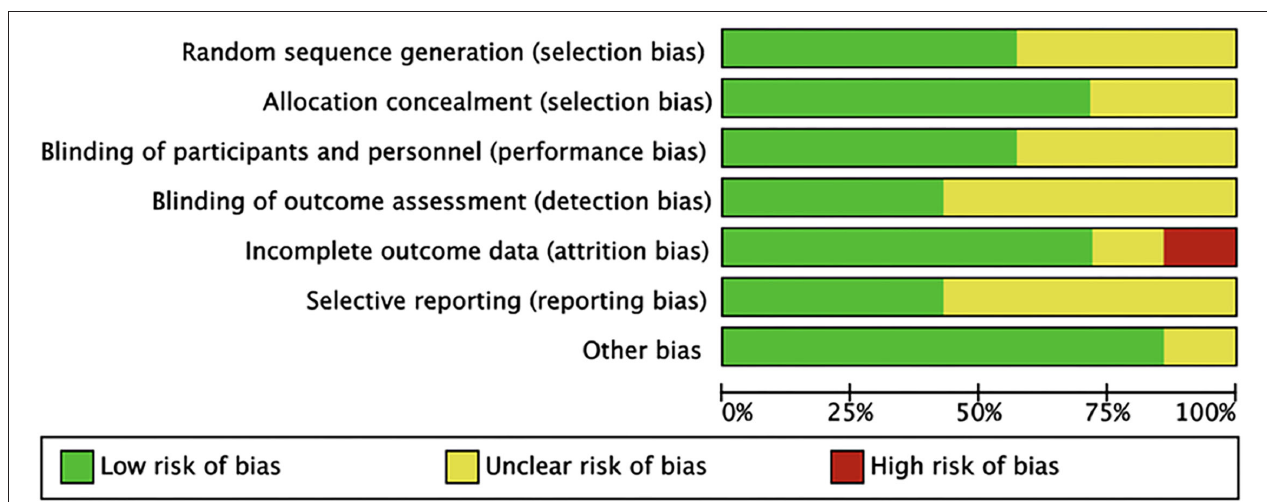
FIGURE 2 | Risk of bias graph. Review authors’ judgements about each risk of bias item presented as percentages across all included studies.